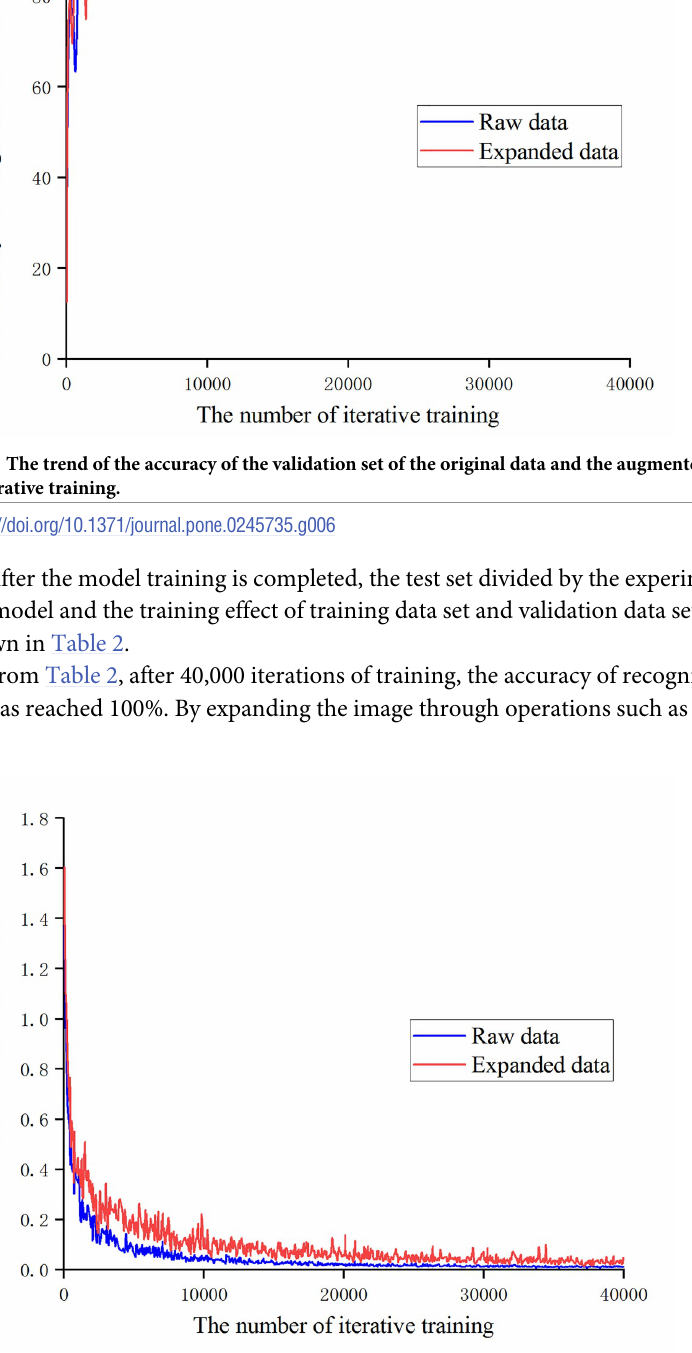
Fig 7. The change trend of the loss function value of the original data and the augmented data with the number of iterative